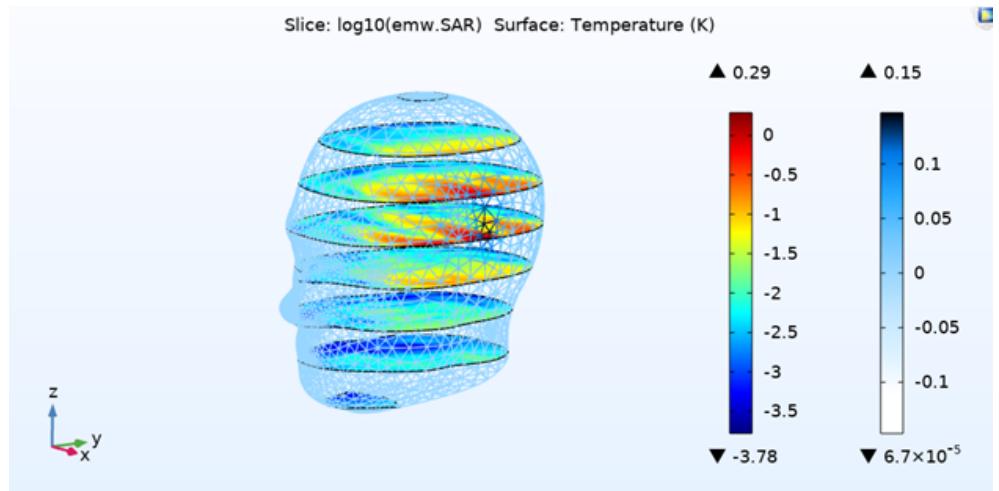
Figure 4. Visualization of the thermal effects in the human head for several horizontal